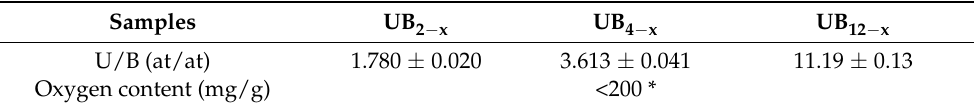
Table 1. U/B ratio obtained by ICPMS and oxygen content determined by direct combustion—infrared absorption.